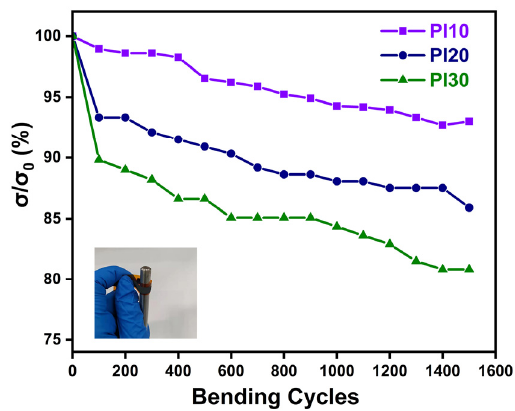
Figure 5. The flexibility of PI10, PI20, and PI30.